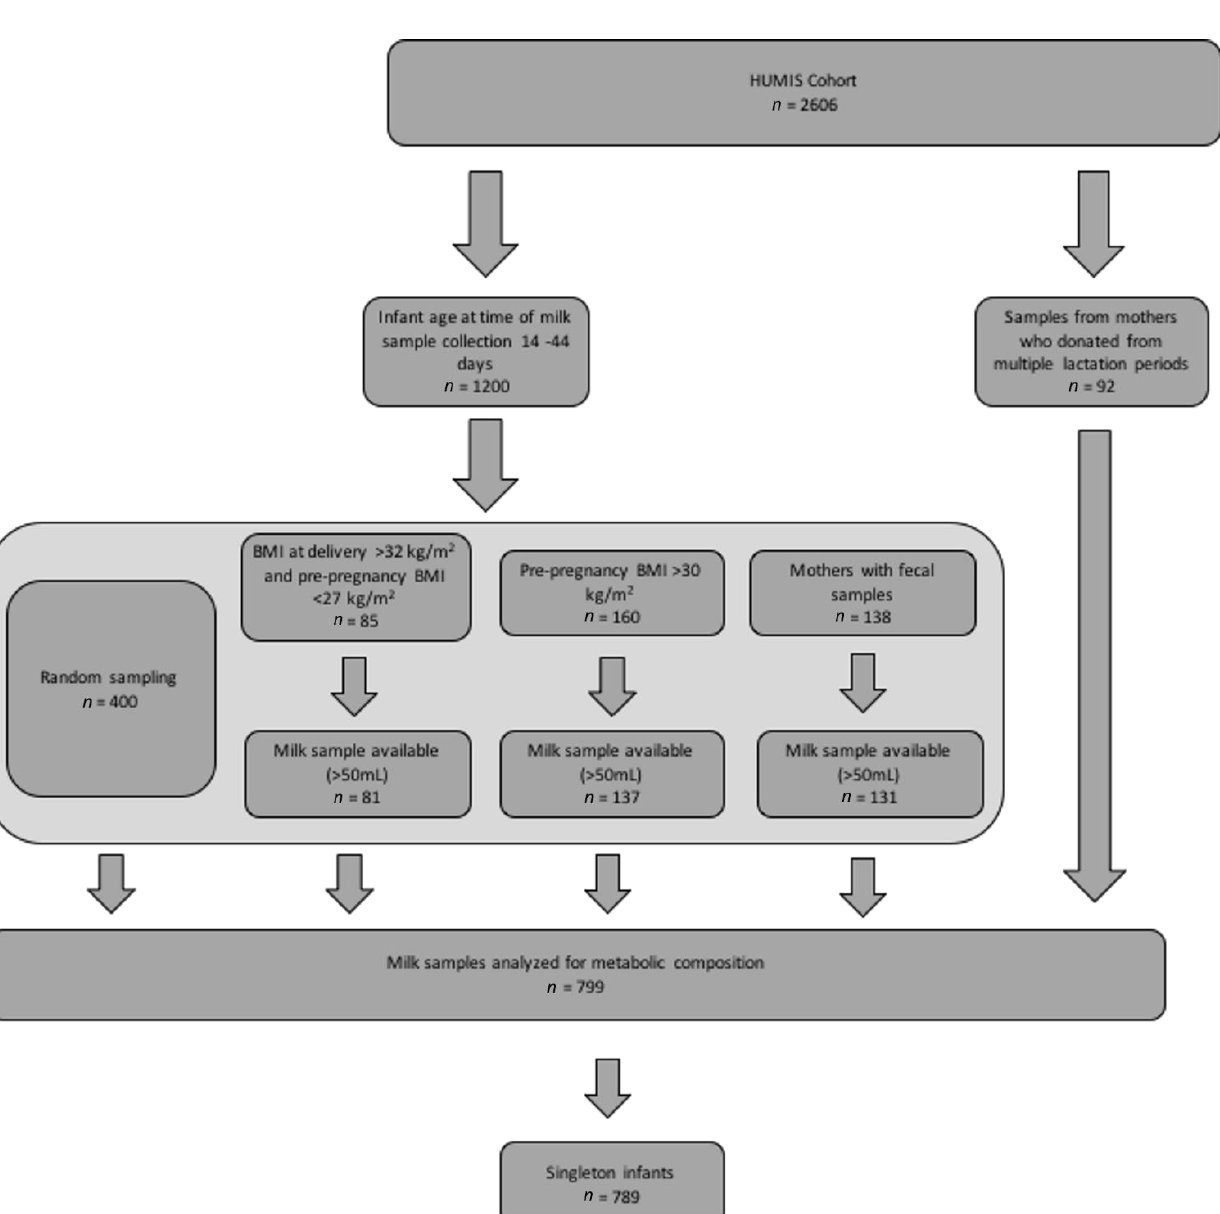
Figure 1. Participant flow diagram for present analysis. Legend: This figure describes the sampling process by which the milk samples for the present analysis ( n = 789) were selected from the Norwegian Human Milk Study (HUMIS) cohort ( n = 2606). BMI stands for body mass index.